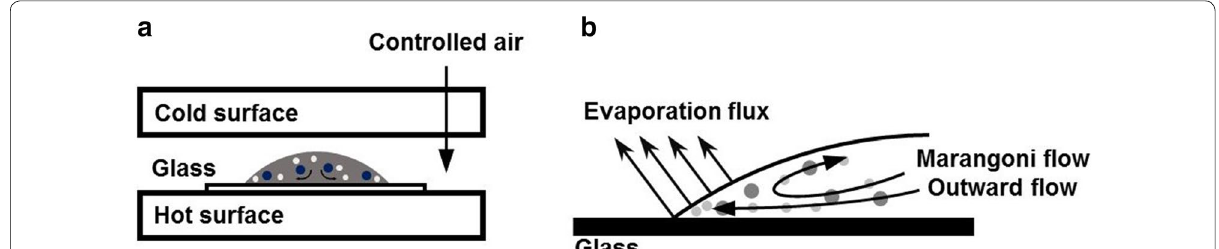
Fig. 1 a Experimental set of evaporation of droplet in temperature- and humidity-controlled chamber. b Flow of different-size particles at contact line of evaporating